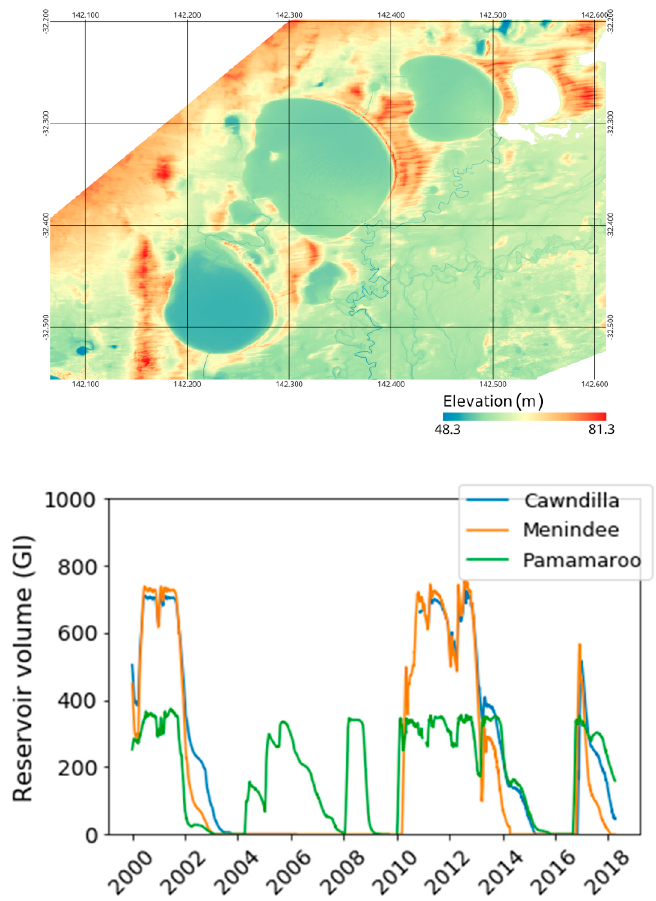
Figure 4. Time series of volume storages for the Menindee lakes and LiDAR elevations. One GL is equivalent to 10 6 m 3 .